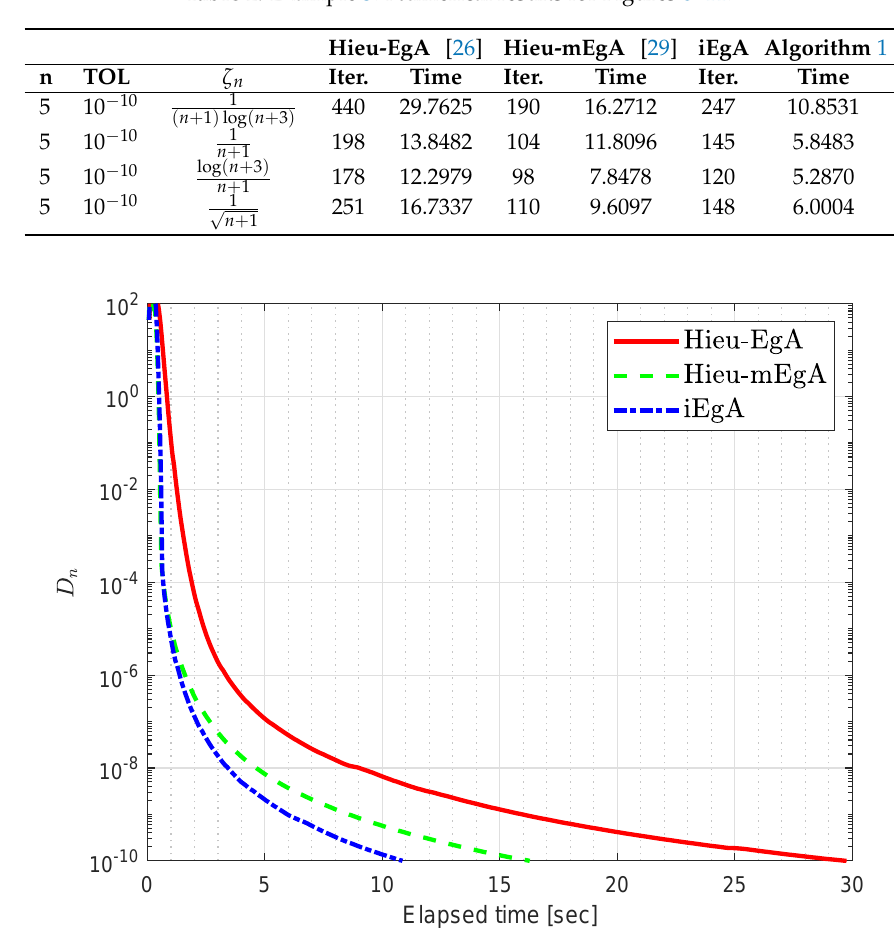
Figure 8. Example 3: Numerical comparison for Algorithm 1 while ζ n = 1